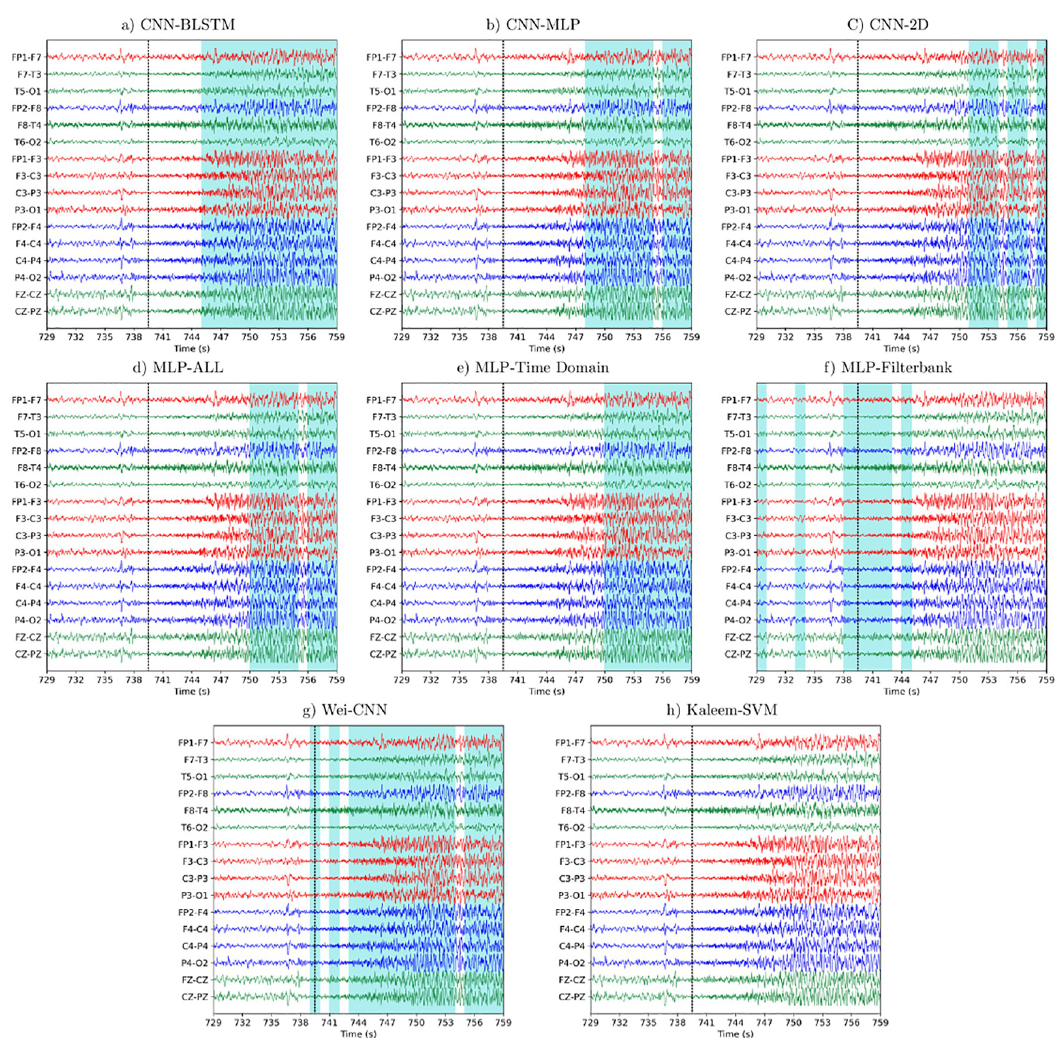
Fig 7. EPViz visualizations of seizure detections from each model. Detected seizures are shown superimposed in blue on the EEG. Annotated seizure onset at 739 seconds is shown by the vertical dashed line. The CNN-BLSTM shows a contiguous seizure detection with low latency while alternative models show higher latency, non-continuous detection, or